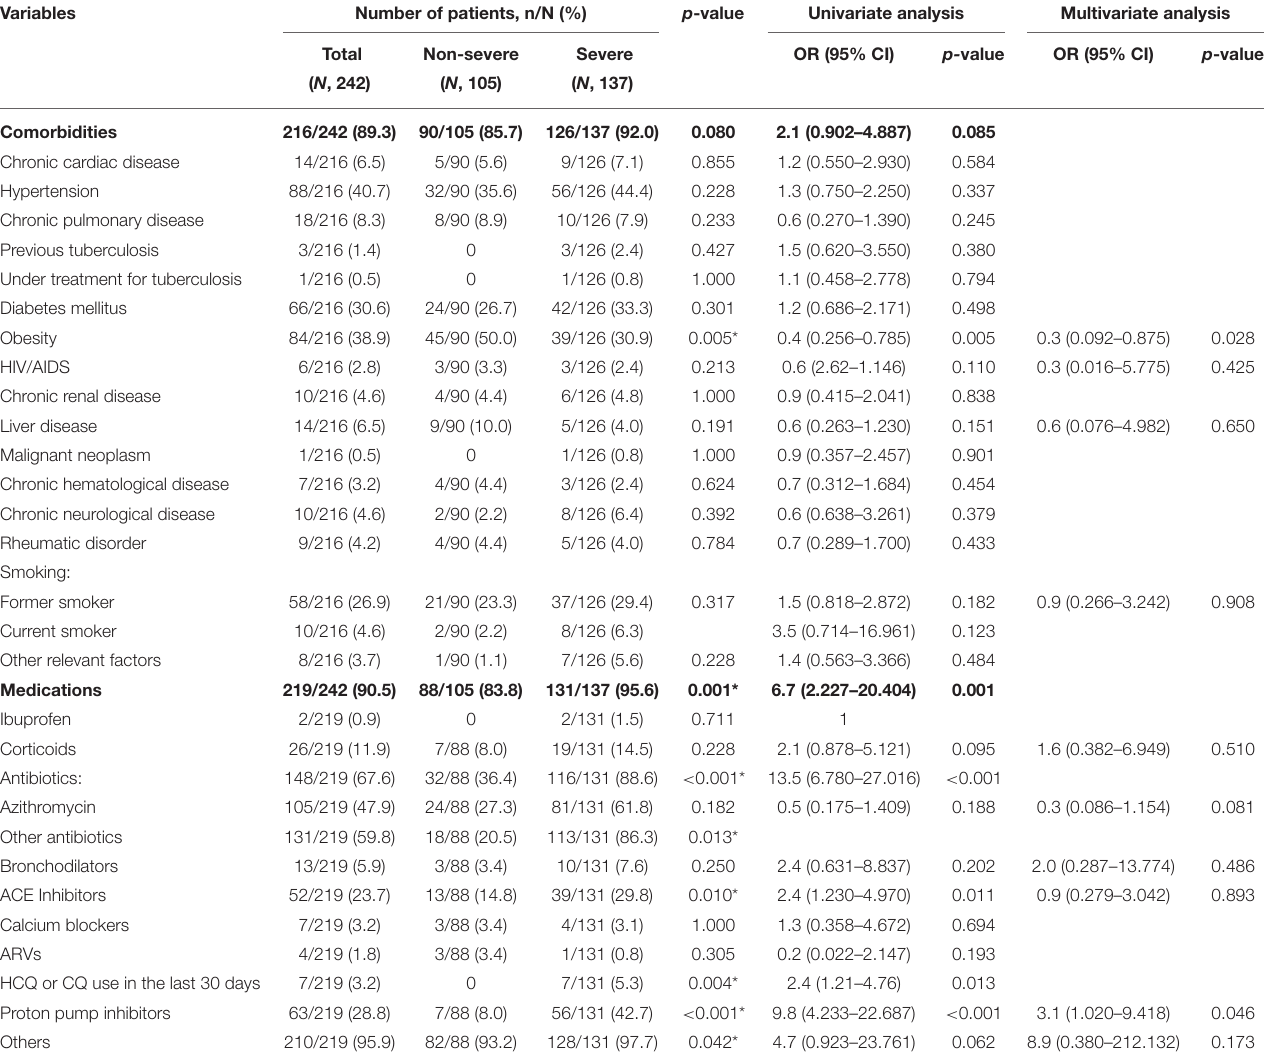
TABLE 2 | Clinical and medical history of patients at baseline, with univariate and multivariate analysis of associations between COVID − 19 severity and baseline